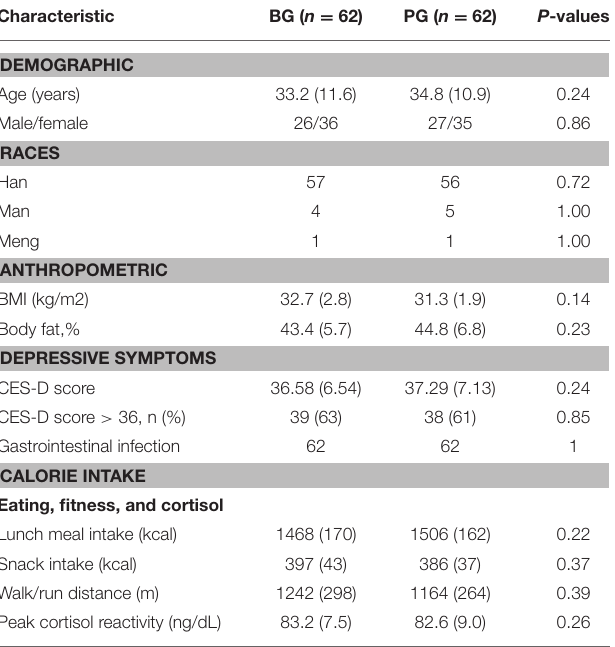
TABLE 2 | The baseline clinical characters of two groups.